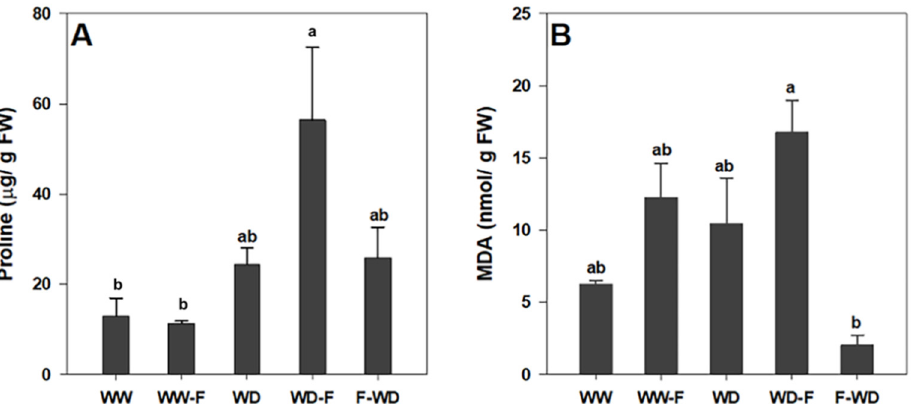
Figure 5. ( A ) Proline content and ( B ) malondialdehyde content (MDA) of grapevines exposed to WW (well-watered control); WW-F (well-watered fungal inoculation); WD (water deficit); F-WD (inoculation before water deficit); WD-F (inoculation after water deficit). Different lowercase letters indicate significant differences among the five treated groups ( p ≤ 0.05).